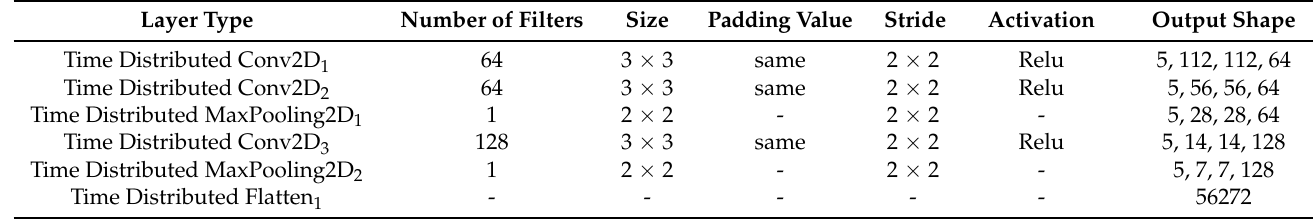
Table 2. Description of LW CNN architecture used in EADN